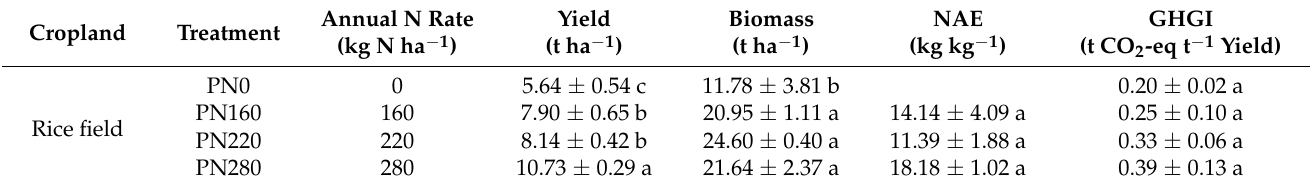
Table 3. Yield, biomass, N agronomic efficiency (NAE), and greenhouse gas intensity (GHGI) for the rice-growing season. Values are means ± SE ( n = 3). Different letters in a single column indicate a significant difference between treatments at the 0.05 probability level. NA, not available. Means that do not share a letter are statistically significantly different from each other ( p <